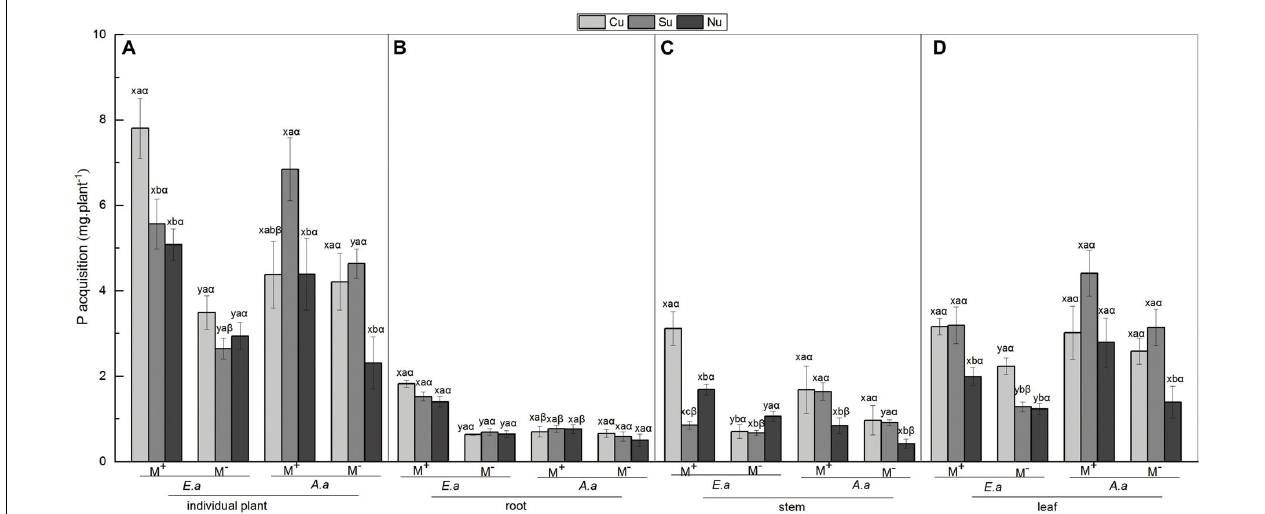
FIGURE 4 | P acquisition of E. adenophorum and A. annua seedlings and its allocation to root, stem and leaf. Abbreviations: E. a and A. a ; M + and M − ; Cu and Su and Nu, meaning same as in Figure 2 . The lowercase letters x and y, (a, b, c). The Greek letters α and β above the bars, they mean the same as in Figure 2